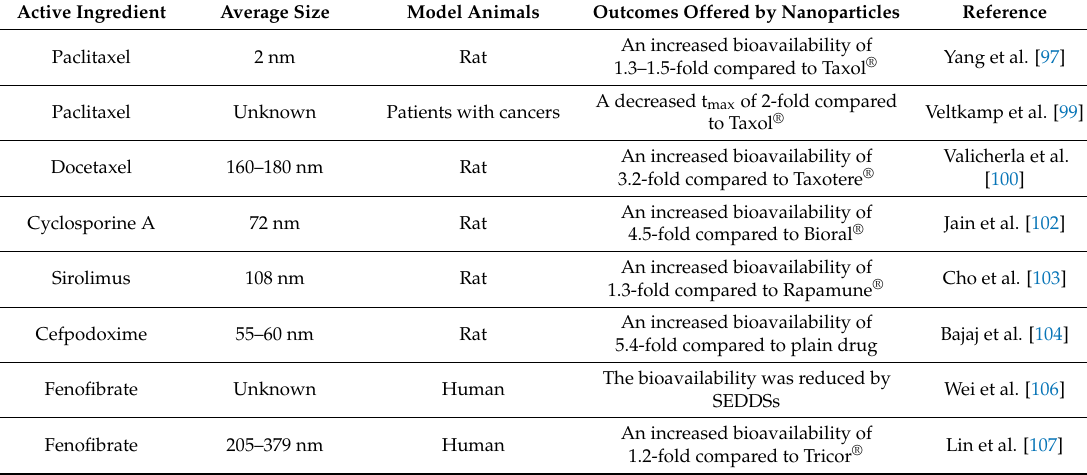
Table 2. Characterization of self-emulsifying drug delivery systems (SEDDSs) incorporated with D - α -tocopheryl polyethylene glycol succinate (TPGS) as the surfactants for enhancing the oral absorption of